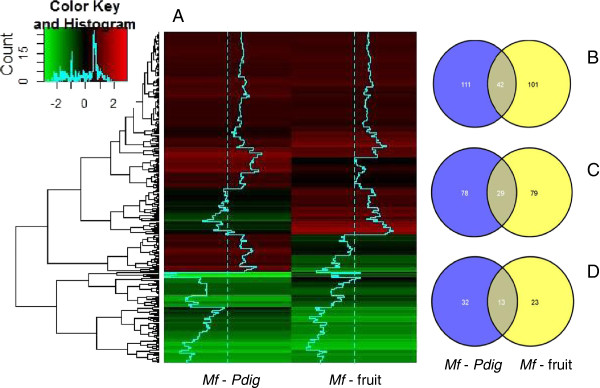
Expression profiles of Metschnikowia fructicola.  Two-dimensional hierarchical cluster heat map of differential expression profiles for 254 genes from Mf-Pdig and Mf-fruit interactions (A). Genes with increased expression are shown in red, genes that were downregulated are colored green, and those showing no change relative to expression in are in brown. Color intensity is proportional to differential expression (log2 Fold Change). Venn diagram showing all differential expressed (B), up regulated (C) and down regulated (D) genes in Mf-Pdig and Mf-fruit interactions. The number of genes commonly expressed in Mf-Pdig and Mf-fruit interactions is provided in the overlapping portions of the circles.